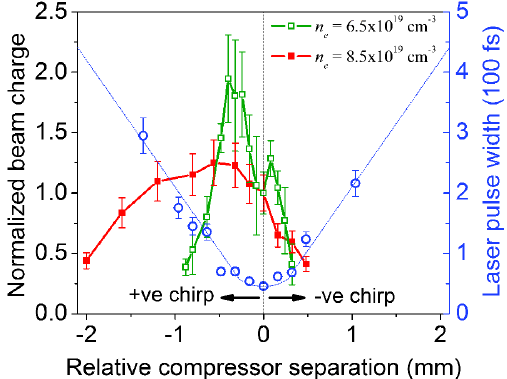
FIG. 2. Variation in the integrated electron beam charge at two different plasma densities (solid squares: 8 : 5 (cid:3) 10 19 cm (cid:4) 3 ; and hollow squares: 6 : 5 (cid:3) 10 19 cm (cid:4) 3 ) with compressor grating pair separation (chirp) measured with respect to the ‘‘zero’’ setting (separation corresponding to minimum pulse duration). The total charge for zero setting of the compressor is 2 and 8 nC, respectively, for plasma density 6 : 5 (cid:3) 10 19 cm (cid:4) 3 and 8 : 5 (cid:3) 10 19 cm (cid:4) 3 . The variation of the laser pulse width (circles) with grating separation is also